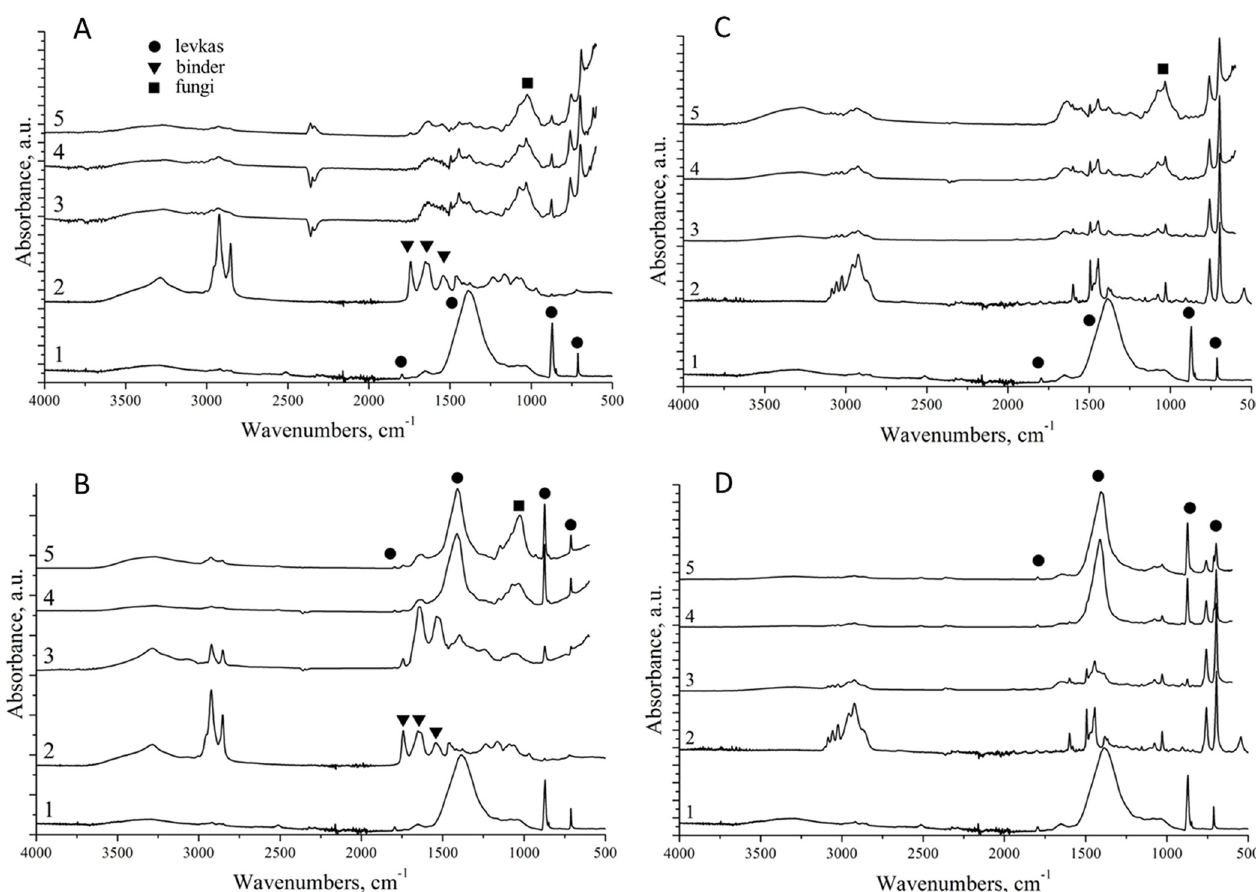
Fig 5. Micro-FTIR spectroscopy of inoculated mock layers. Analysis was performed for inoculated samples incubated for 12 days at 25˚C. (A and B) Mock layer 7 inoculated with sample 106 containing fungus A . amoenus . (C and D) Mock layer 13 inoculated with sample 93W containing fungus A . creber . (A and C) Spectra with microbial sheets. (B and D) Spectra after removal of microbial sheets. 1 –intact levkas, 2 –intact mock layer 15, 3 –periphery of the inoculated zone; 4 –areola zone; 5 –center of the inoculated zone. Absorption peaks: circles–levkas (ground layer), triangles–binder (egg emulsion),